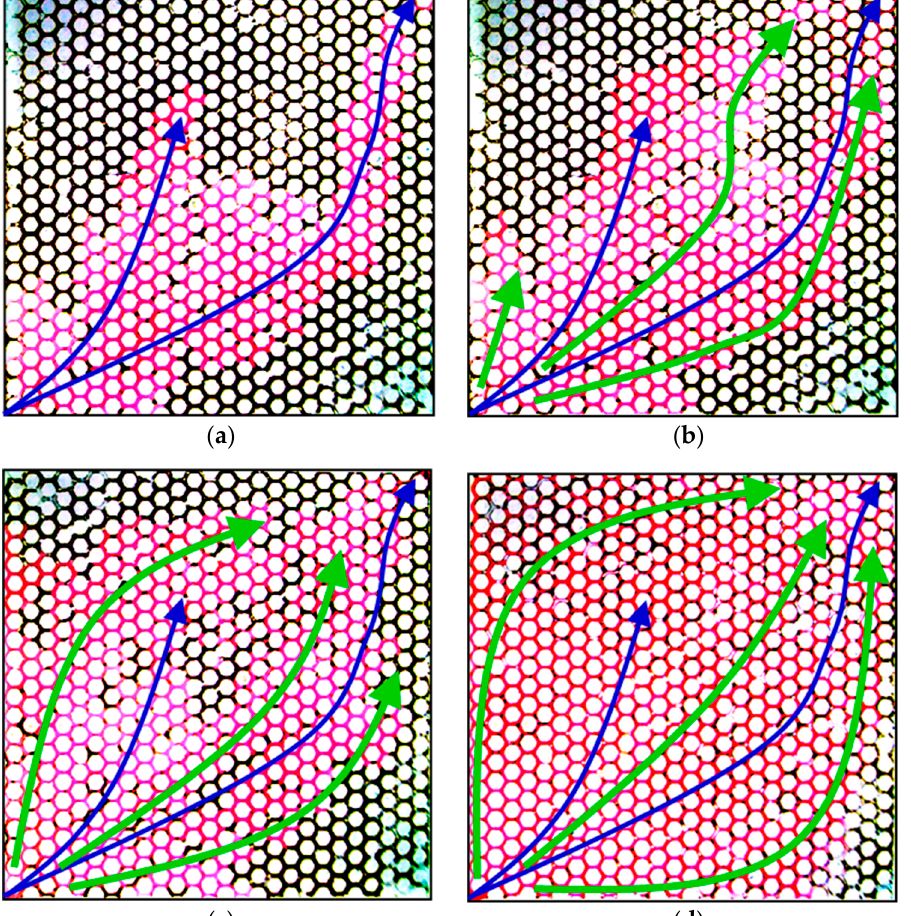
Figure 8. Micrographs of oil displacement experiment using PPG of 2–4 Pa, 60–80 mesh: ( a ) end of water flooding, ( b ) 0.25 PV of PPG flooding, ( c ) 0.5 PV of PPG flooding and ( d ) end of PPG flooding.